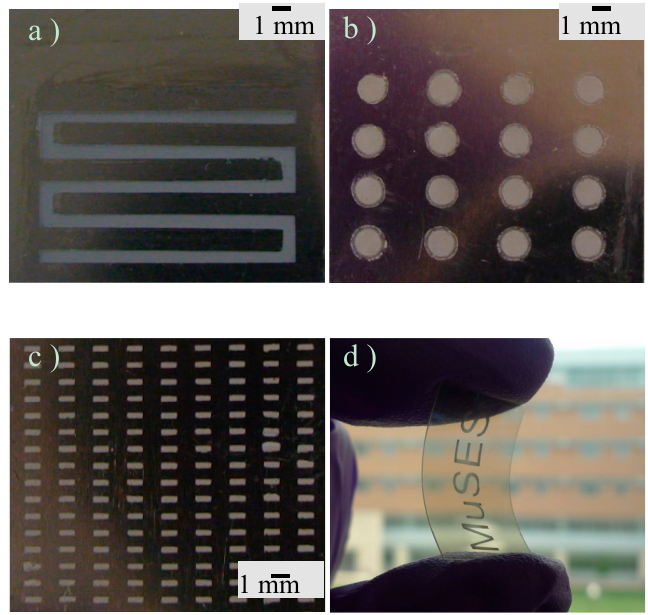
Figure 4. Various patterns of gallium on stainless steel substrates: ( a ) 1 mm-wide serpentine lines; ( b ) circles of 2 mm in diameter; ( c ) an array of 1 mm × 300 μ m rectangular bars. ( d ) Letters on flexible